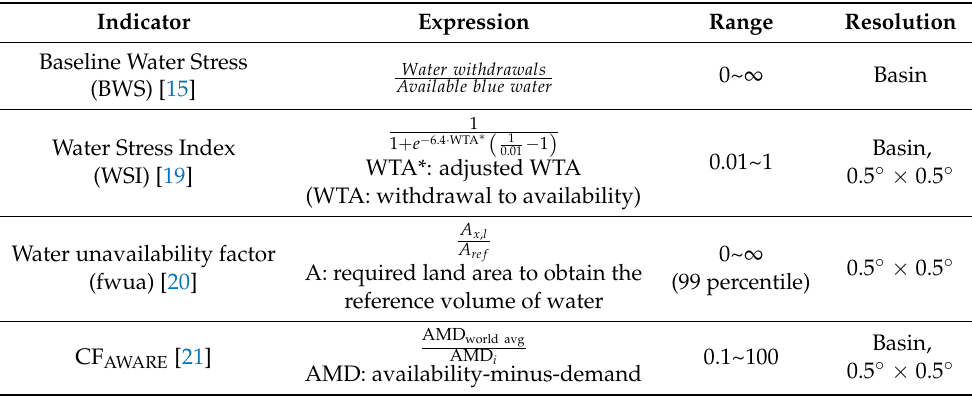
Figure 1. Location of the Tone and the Arakawa River Basins. Table 1. Description of characterization factors.